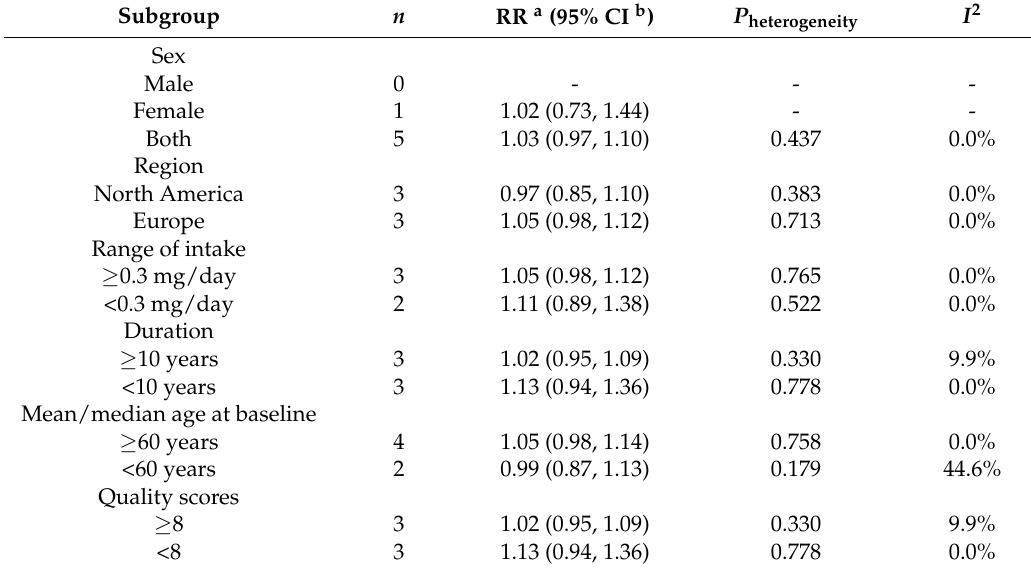
Table 3. Subgroup analysis for the association of n -3 PUFAs intake and AF risk (highest vs. lowest).